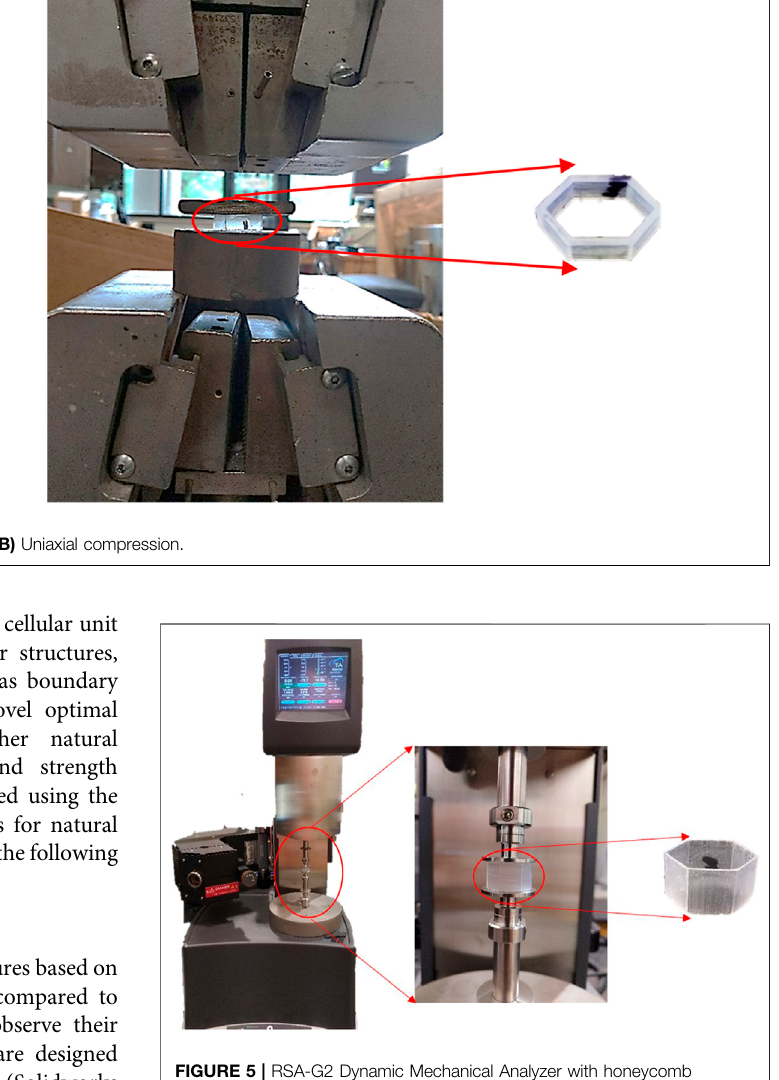
FIGURE 5 | RSA-G2 Dynamic Mechanical Analyzer with honeycomb unit cell